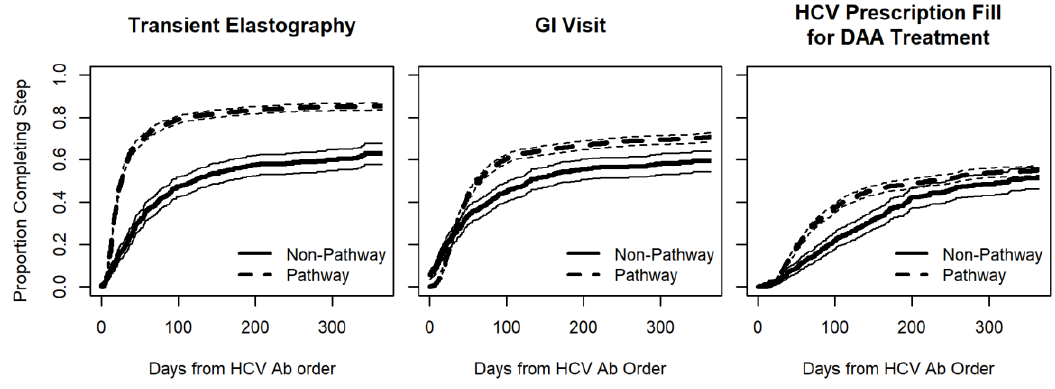
Figure 1. Time-to-event model for HCV care